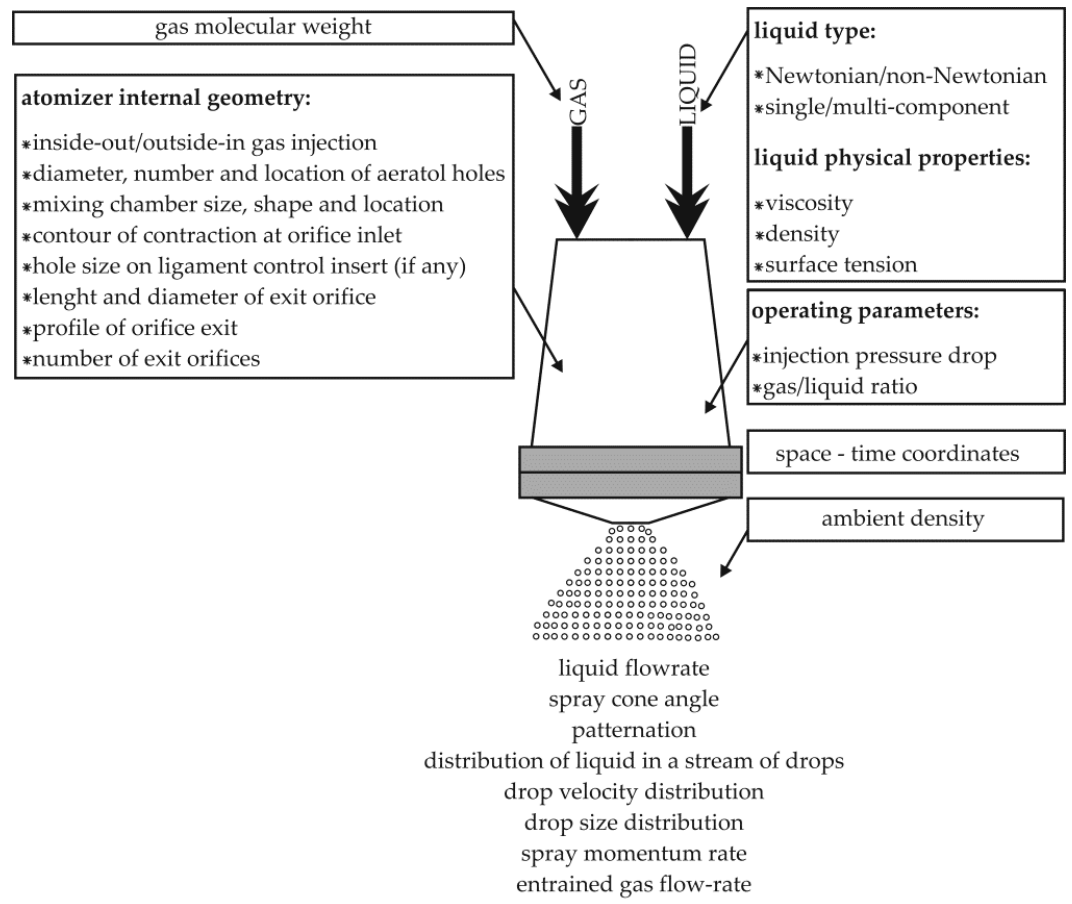
Figure 1. Graphical representation of the liquid atomization process, taking into account the influence of individual parameters [7,8].